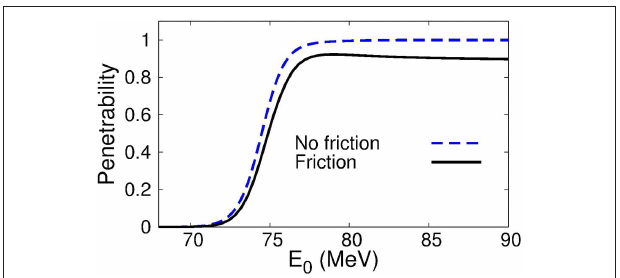
FIGURE 1 | Energy dependence of the penetrability of the Coulomb barrier for the 16 O+ 208 Pb reaction. The dashed line shows the result without friction, while the solid line is for the result with